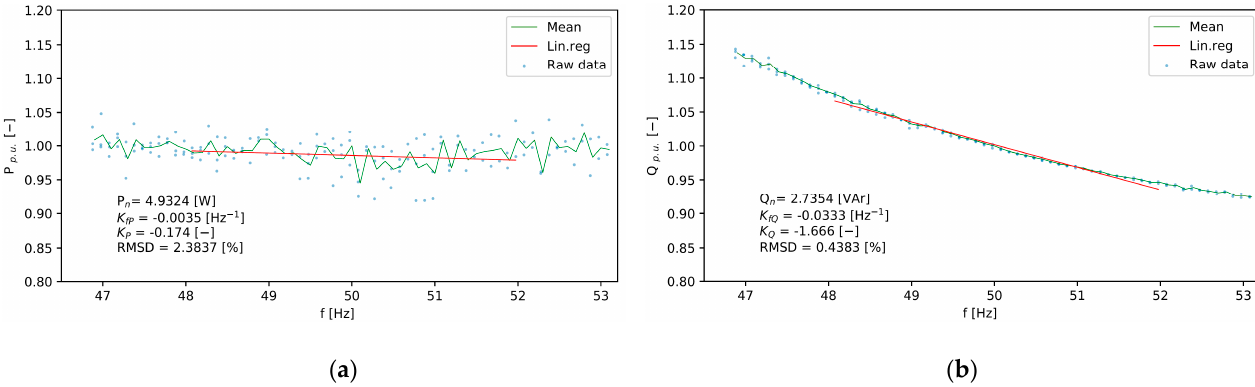
Figure 5. Example of the analyzed characteristics of Wi-Fi router ( a ) K P , K fP ; ( b ) K Q , K fQ .